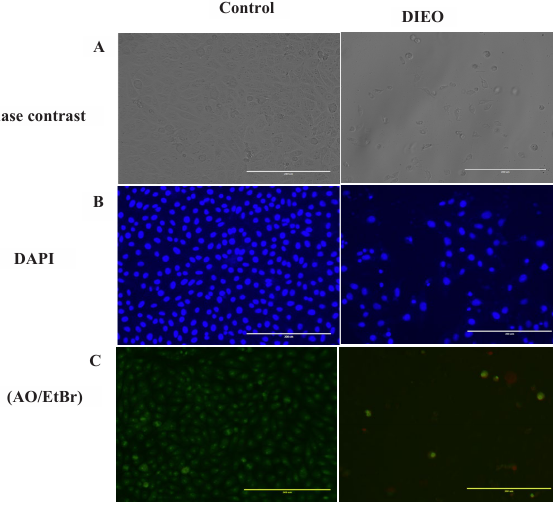
Figure 3: Morphological changes and apoptosis detection in MCF 7 cells treated with DIEO. MCF7 cells were cultured and treated with the IC 50 of DIEO for 24h. (A) Morphological changes seen under light phase contrast microscope, (B) Apoptotic cells were investigated by fluorescence DAPI staining, (C) Cells were stained with a mixture of (AO: Acridine Orange, EtBr: Ethidium Bromide). Viable cells excluded EtBr and their nuclei were bright green, while apoptotic cells were orange to red color.